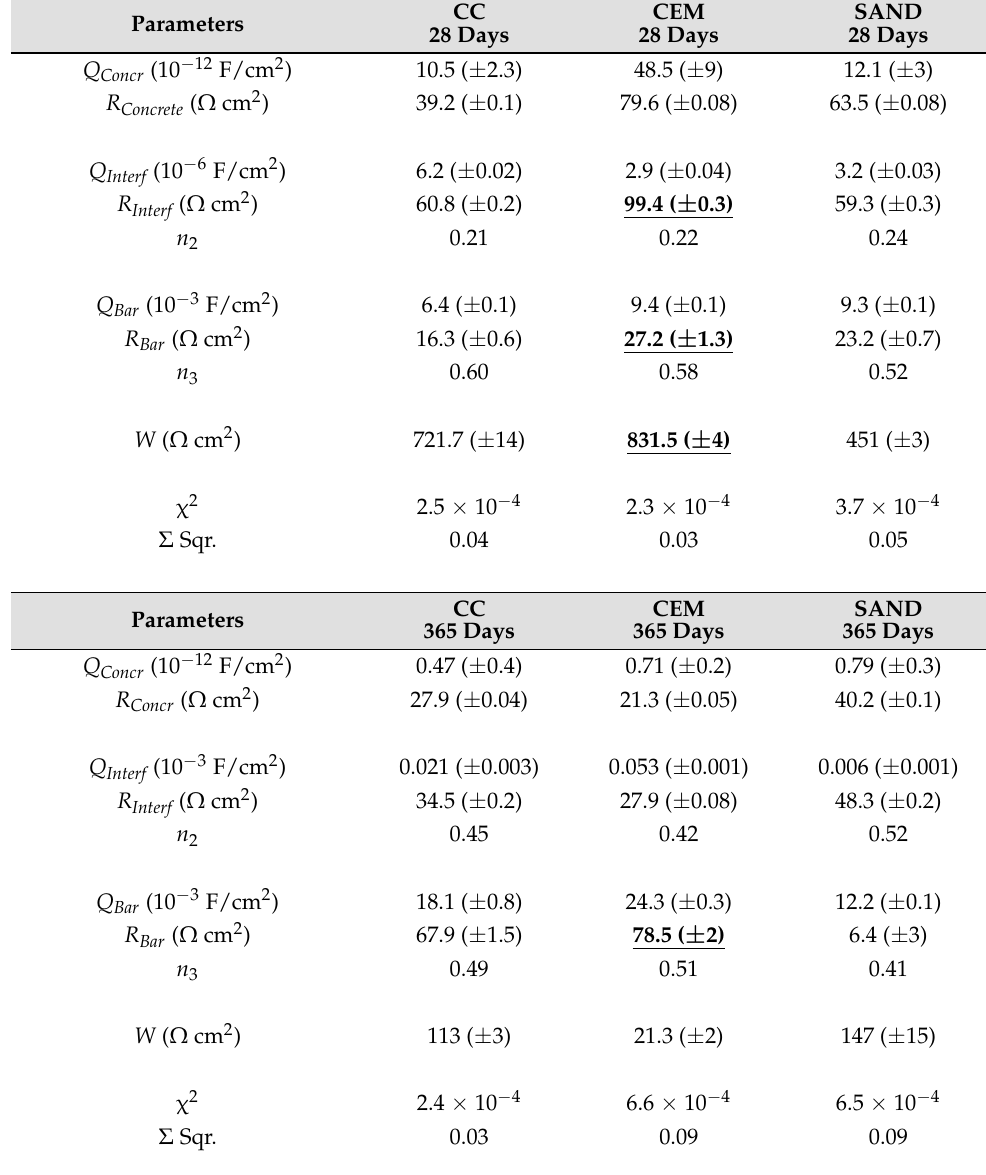
Table 4. Impedance parameters determined using equivalent circuit (EC) shown in Figure 8 with steel bars embedded in distinct concretes over 28 and 365